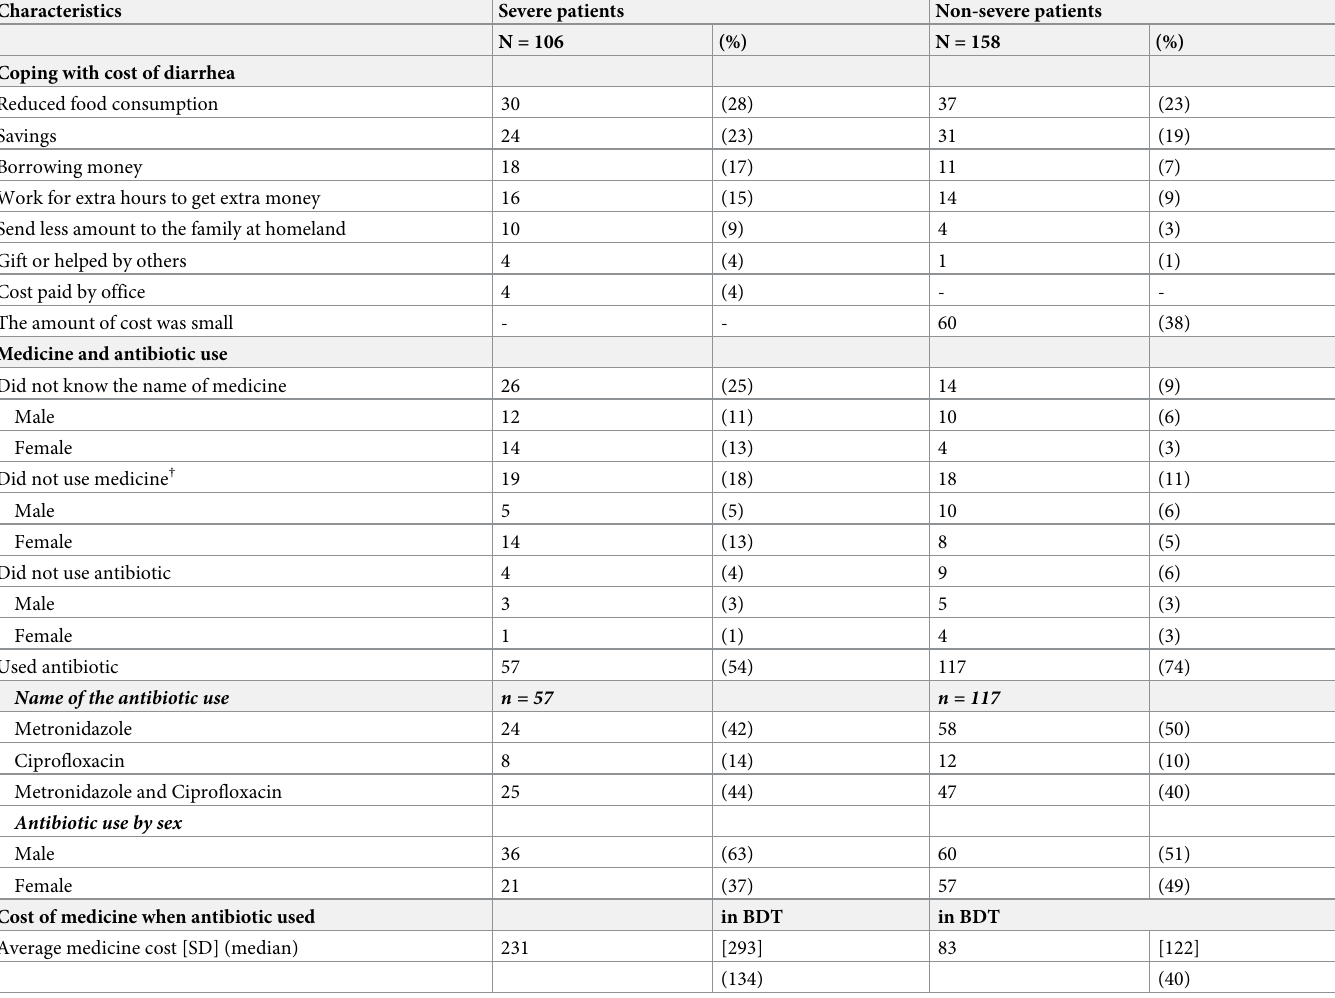
Table 5. Coping strategies and use of antibiotic among severe and non-severe diarrhea patients of Tongi Township in Dhaka, Bangladesh from October 2015 to June 2016.